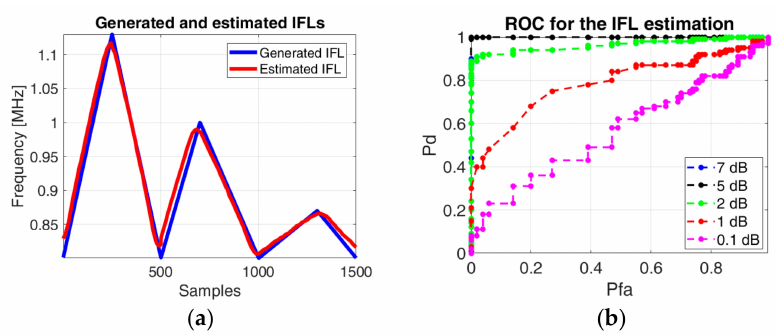
Figure 14. ( a ) The IF law used for generation (in blue) and the phase diagram based estimated IF law (in red); ( b ) The receiver operating characteristic (ROC) for the IF law